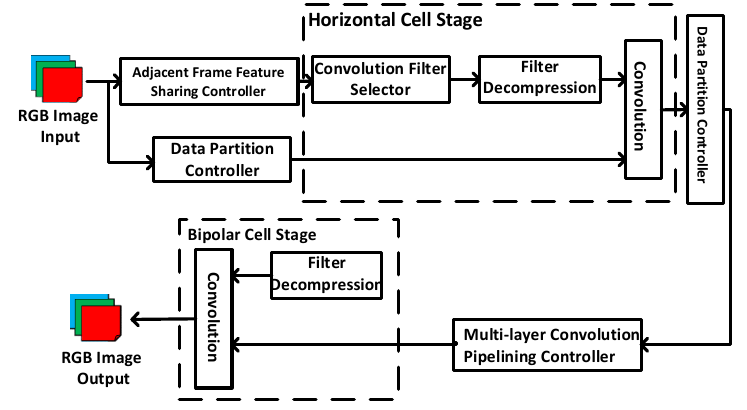
Figure 2. Architecture of proposed biological retina inspired tone mapping processor.